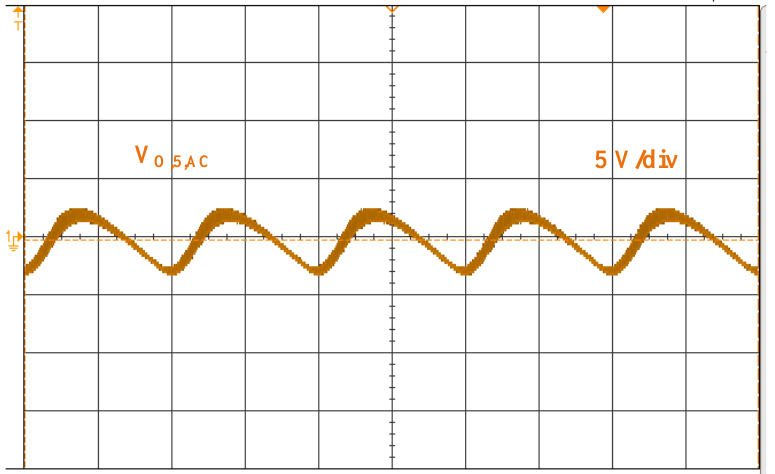
Figure 18. Output voltage ripple V o,5,AC for maximum output voltage.